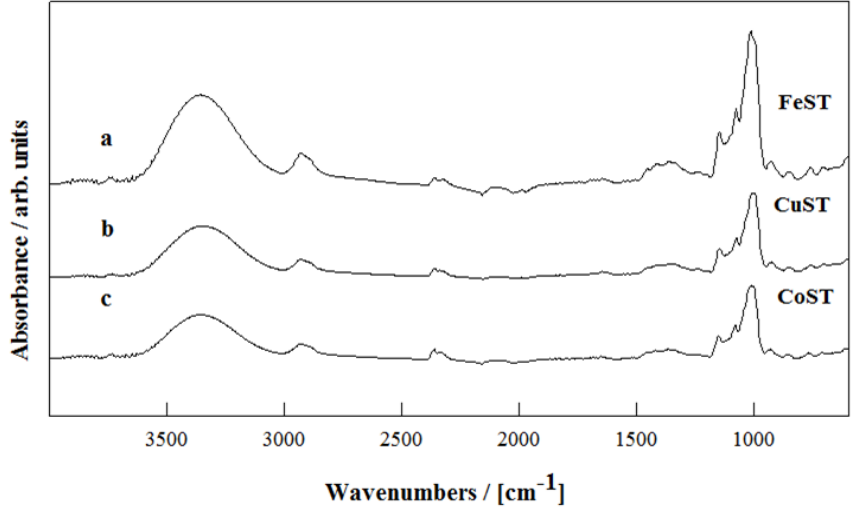
Figure 6. DRIFTs spectra of: ( a ) FeST; ( b ) CuST and ( c ) CoST.